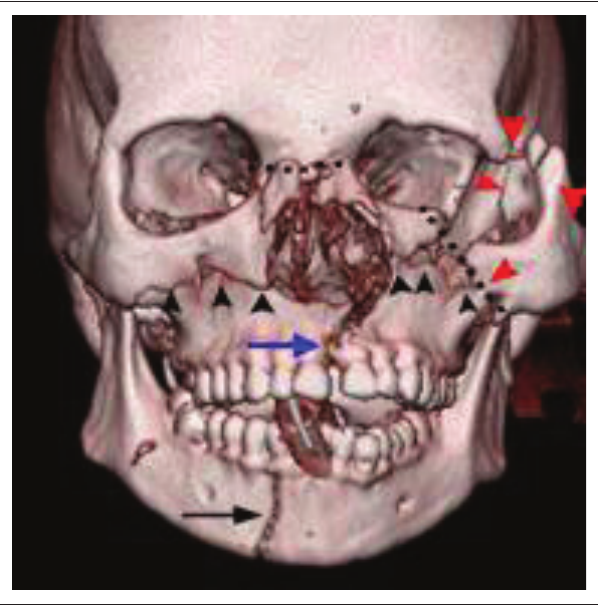
MVC, motor vehicle collision; ZMC, zygomatico-maxillary complex. FIGURE 2: 3D reconstructed CT scan of the facial bones of a 38-year-old man involved in a MVC as a driver. Bilateral Le Fort I (black arrowheads) and left Le Fort II fractures (dotted lines). Note the presence of the left ZMC (red arrowheads) and right parasymphysial mandibular fracture (black arrow), which are the two most common associations with Le Fort injuries. In addition, there is a sagittal fracture of the maxilla extending to the alveolar ridge (blue arrow).